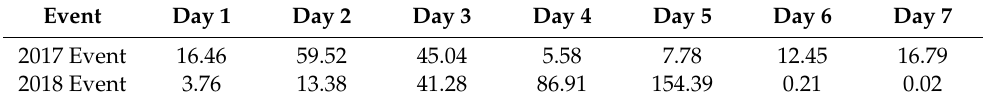
Table 3. Daily rainfall (mm) averaged over 25 gage stations for the two historical events.